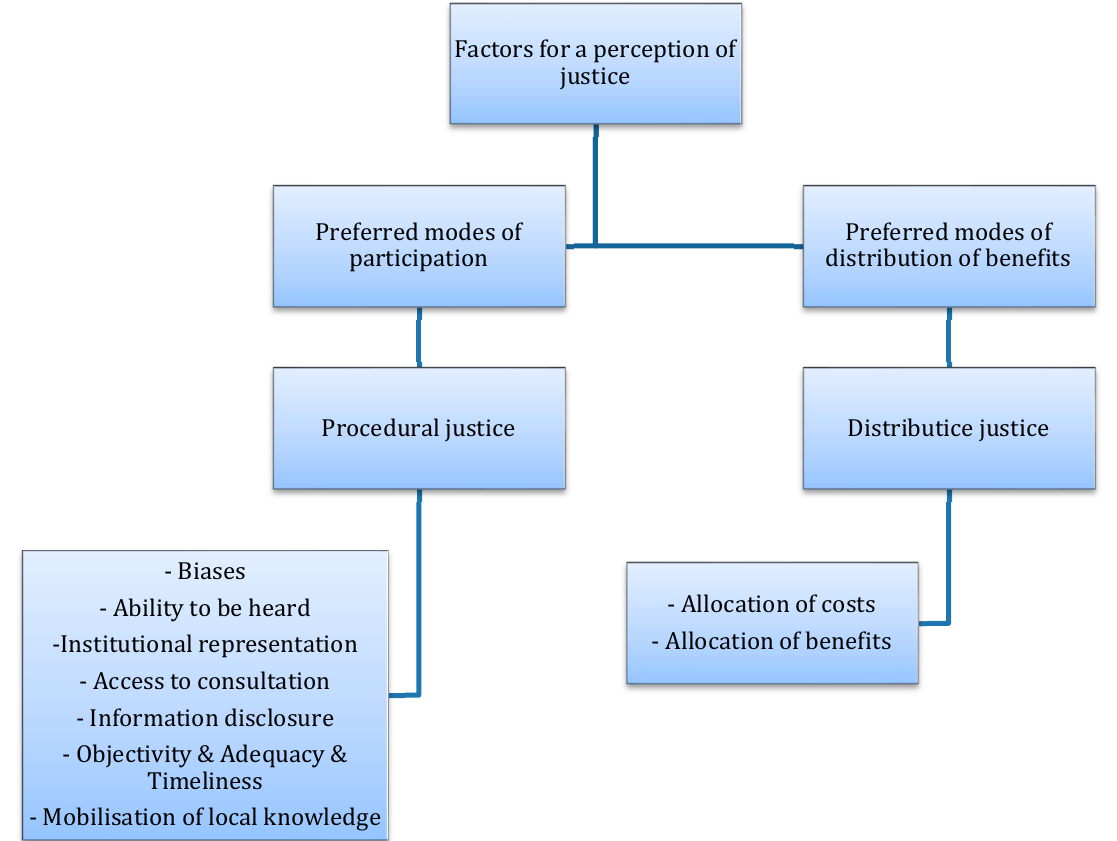
Figure 2. Conceptual framework of this research.